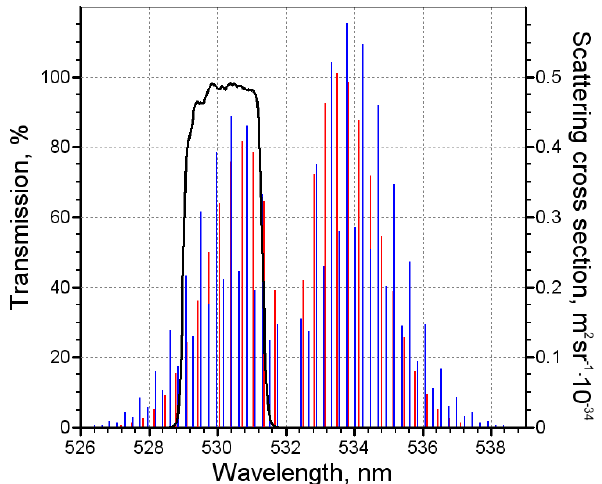
Figure 3. Spectrum of RR scattering by nitrogen (blue) and oxygen (red) for T = 300K together with transmission of the interference filter used in the experiment. Backscatter cross sections of N 2 and O 2 lines are multiplied by 0.79 and 0.21, respectively; laser line is at 532.12nm.